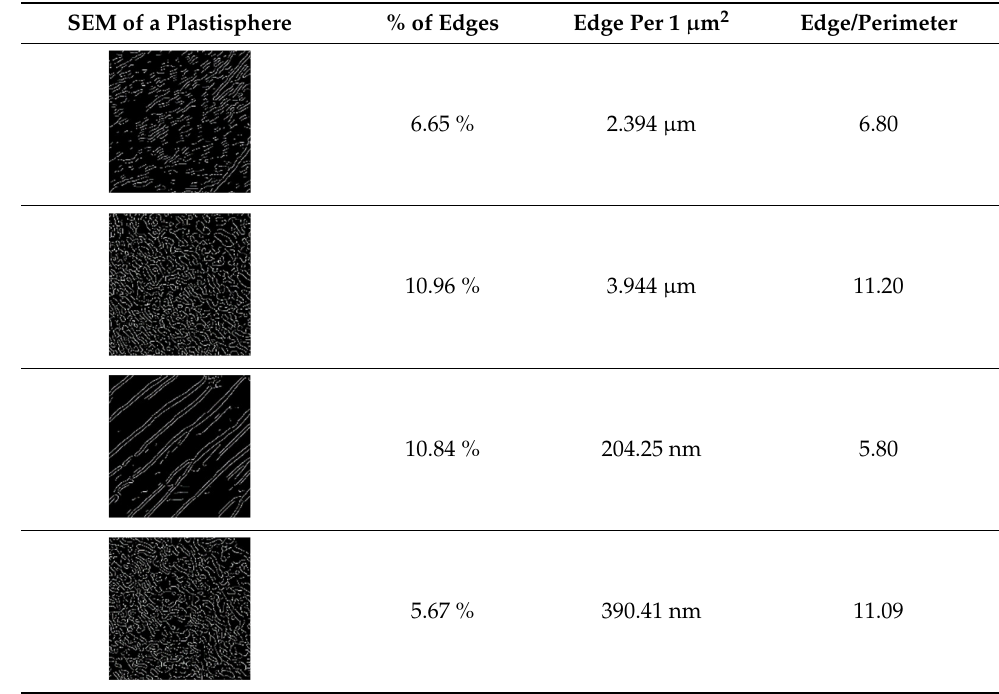
Table 1. Characterization of niches by edges’ length.